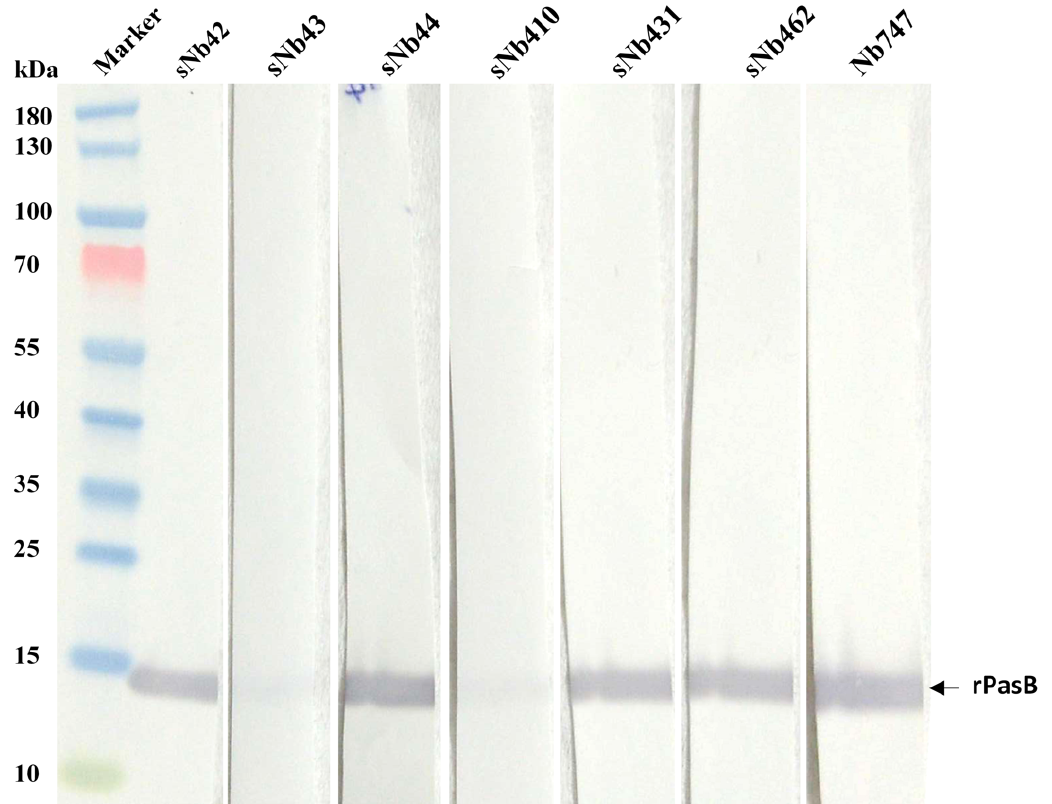
Figure 3. Antigen-specificity of the Nbs. Purified rPasB protein was loaded on the SDS-PAGE and transferred to a nitrocellulose membrane. The membrane was cut into different strips and incubated with the Nbs. The presence of the Nb was detected with monoclonal anti-HA IgG and HRP conjugated anti-mouse IgG.